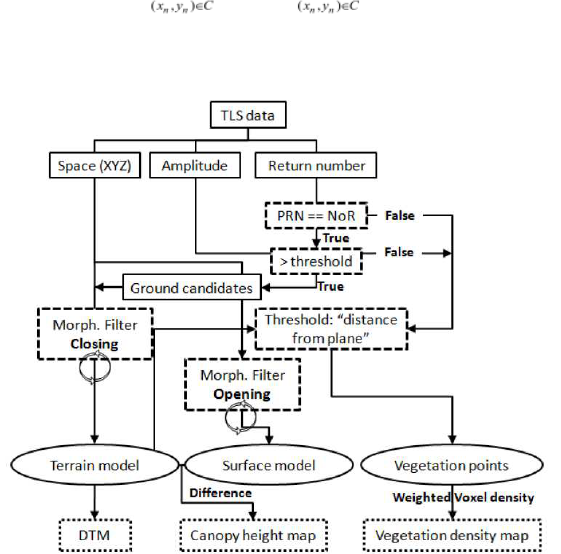
Figure 6: Workflow of the morphological filter; PRN is denotes the point return number, while NoR the total number of returns.